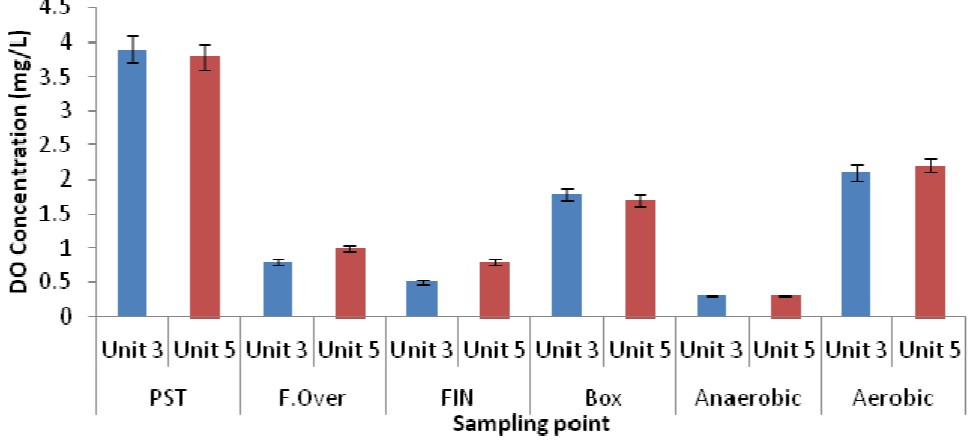
Figure 5. DO concentration in wastewater samples collected from different zones of both Unit-3 and Unit-5 of the Northern Wastewater Treatment